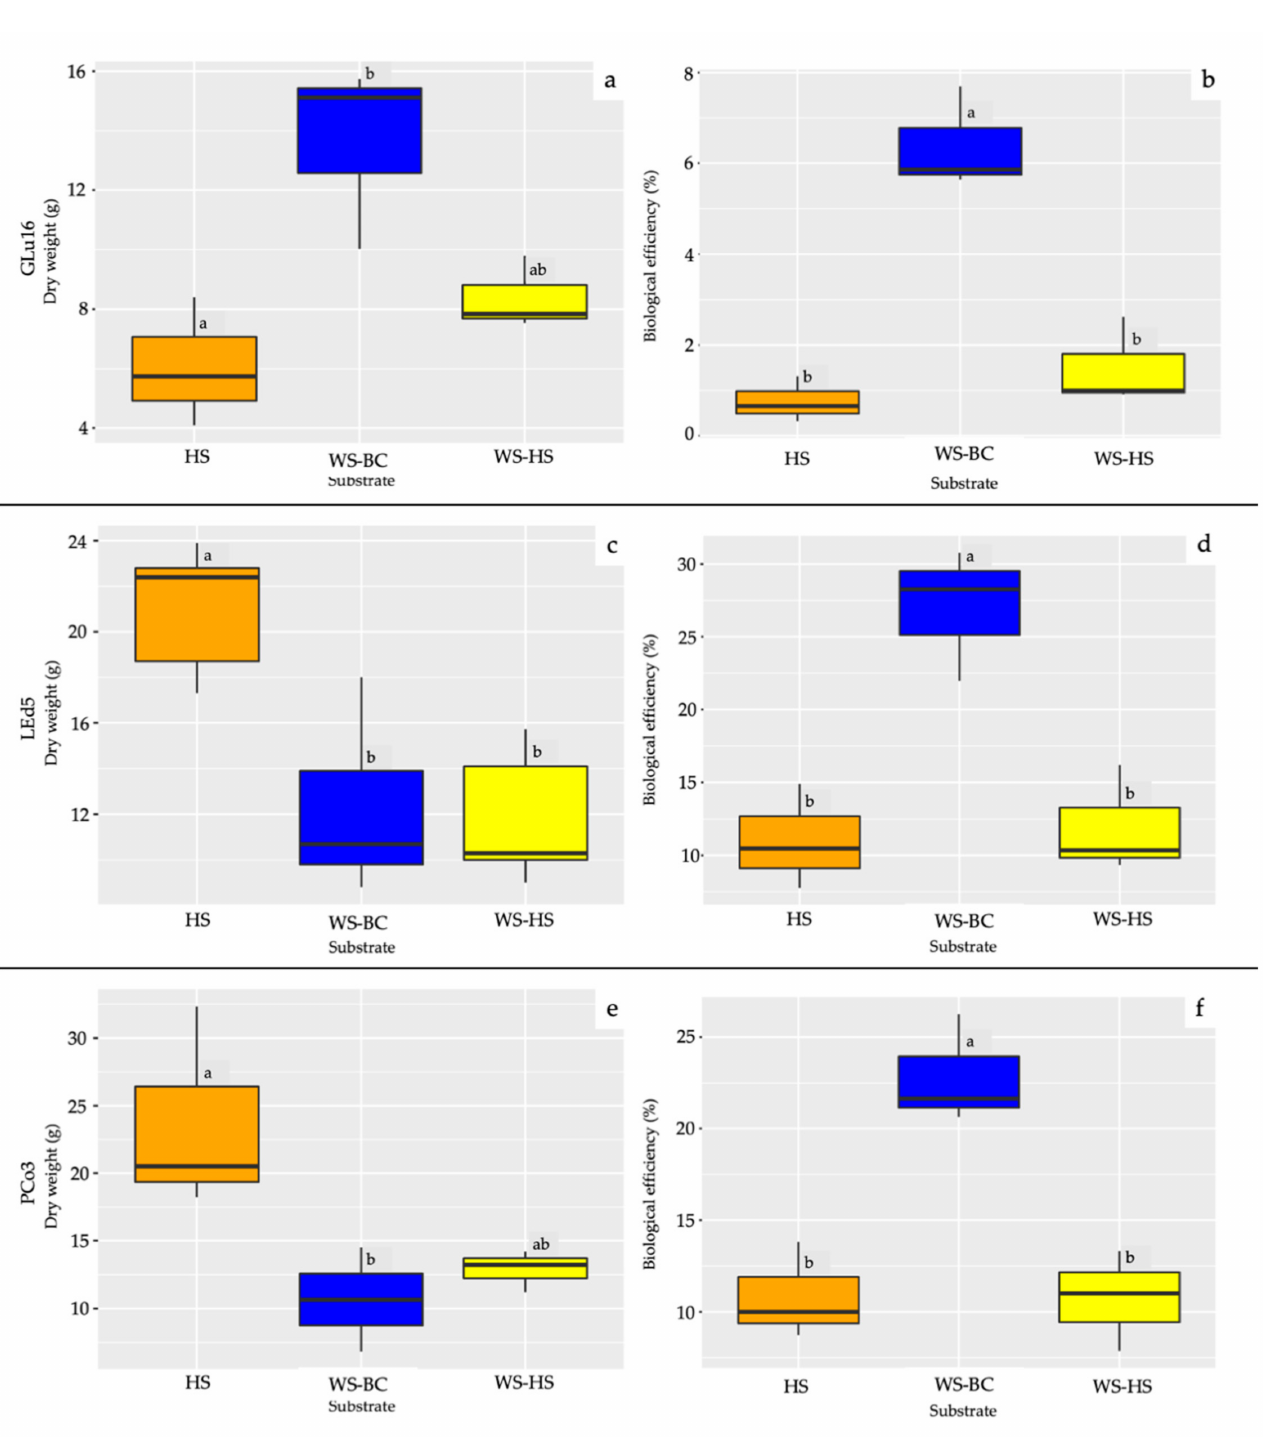
Figure 3. FBP and biological efficiency of ( a , b ) Ganoderma lucidum ; ( c , d ) Lentinula edodes, and ( e , f ) Pleurotus cornucopiae grown on HS (orange), WS-BC (blue), and WS-HS (yellow). Different letters indicate significant differences at p ≤